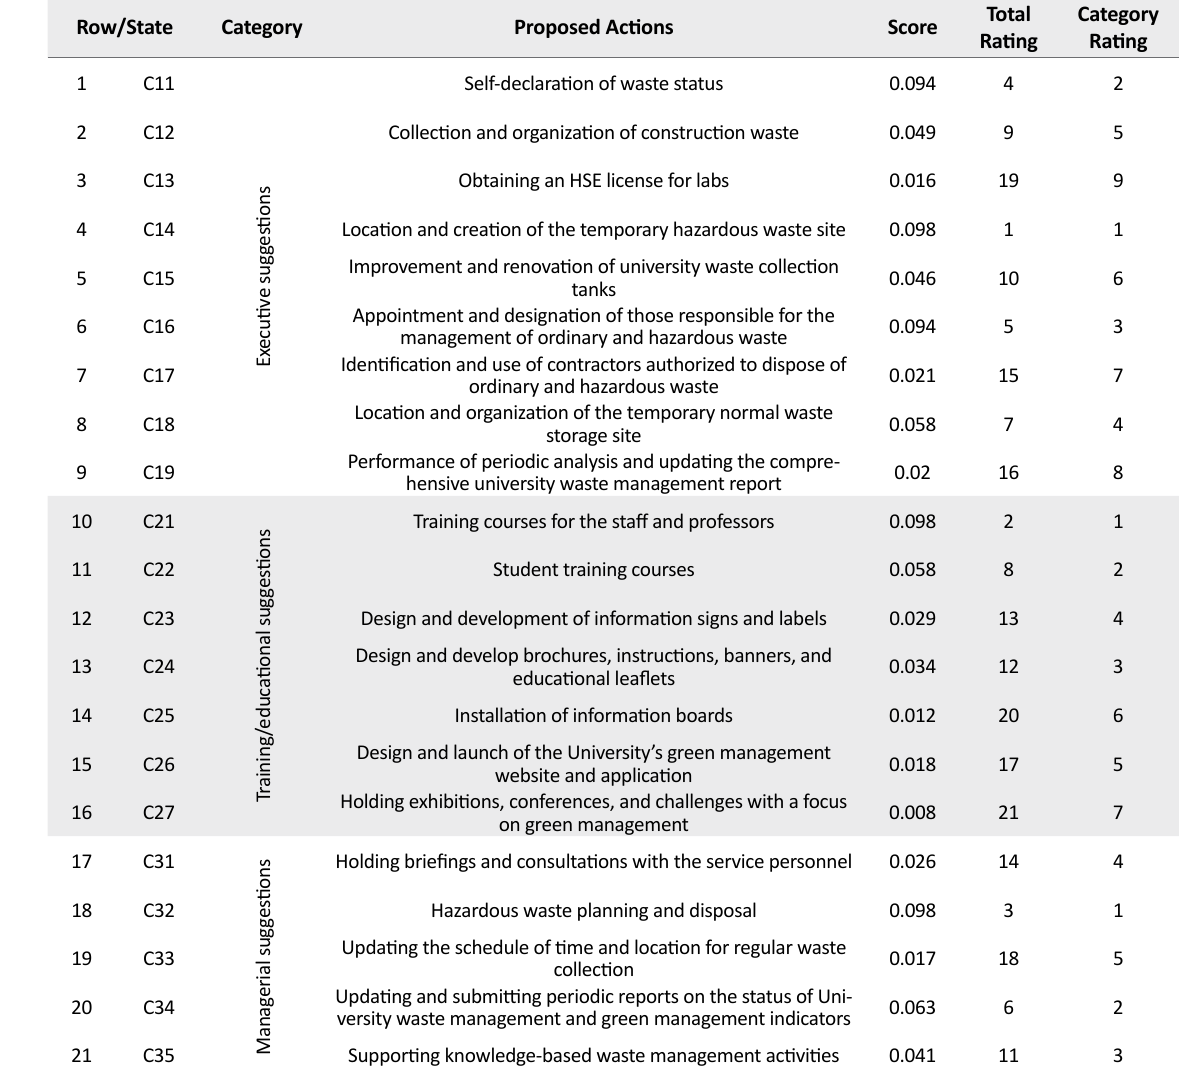
Table 3. Prioritizing measures proposed to improve Kerman Graduate University of Technology’s waste management status